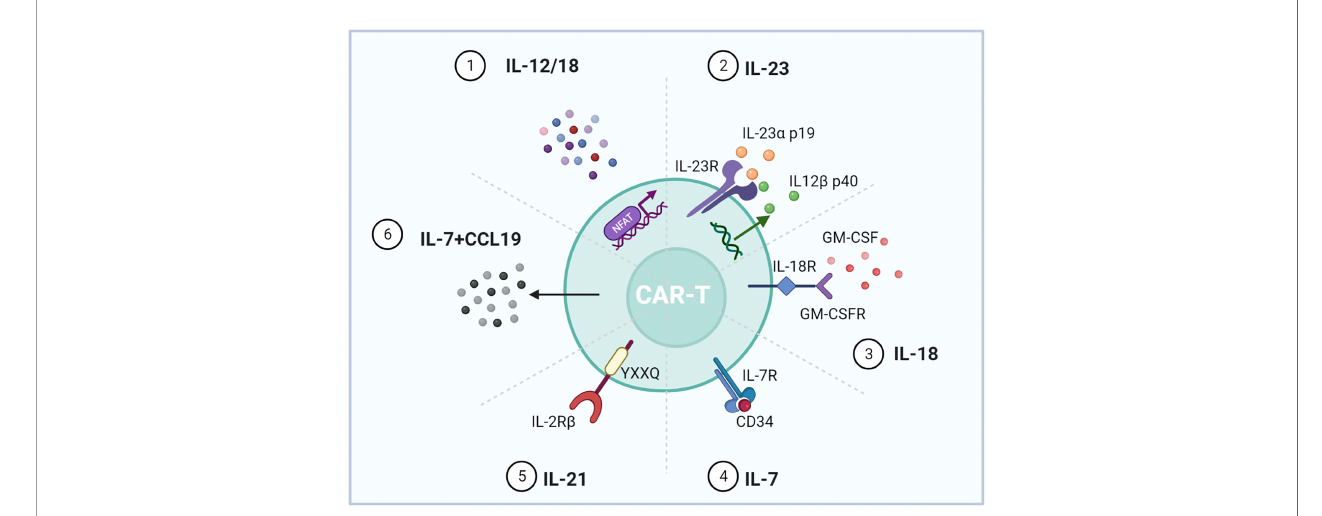
FIGURE 6 | Representative designs of CARs with cytokines and chemokines. Diagrams of CAR mediating cytokine and chemokine expression upon T-cell activation. 1) NFAT activated upon antigen recognition was transduced into T cells to regulate IL-12/18. 2) IL-12 b p40 was overexpressed for IL-23 production accompanied by intrinsic IL-23R and IL-23 a p19. 3) The GM-CSF receptor sensing GM-CSF upon T-cell activation was incorporated with the IL-18 receptor. 4) The IL-7 receptor was enough for the downstream STAT5 activation, and CD34 blocked the effect of exogenous IL-7. 5) IL-2R b with the YXXQ motif could mimic the effect of IL-21. 6) Expressing IL-7 and CCL19 could promote CAR-T migration and recruit DCs and T cells into the tumor. Figure created using